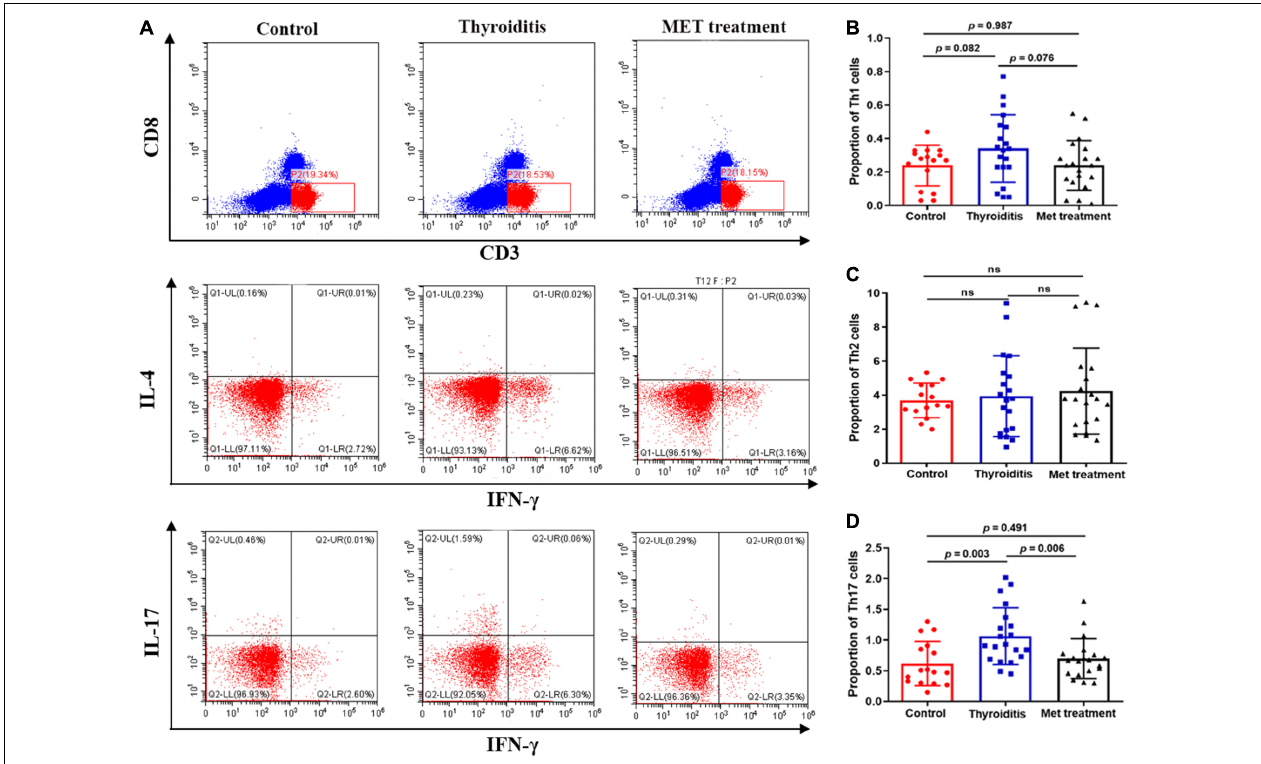
FIGURE 2 | Flow cytometry and statistics of mouse spleen T cells; (A) Flow cytometry diagram, (B) Proportion of Th1 cells, (C) Proportion of Th2 cells, (D) Proportion of Th17 cells.